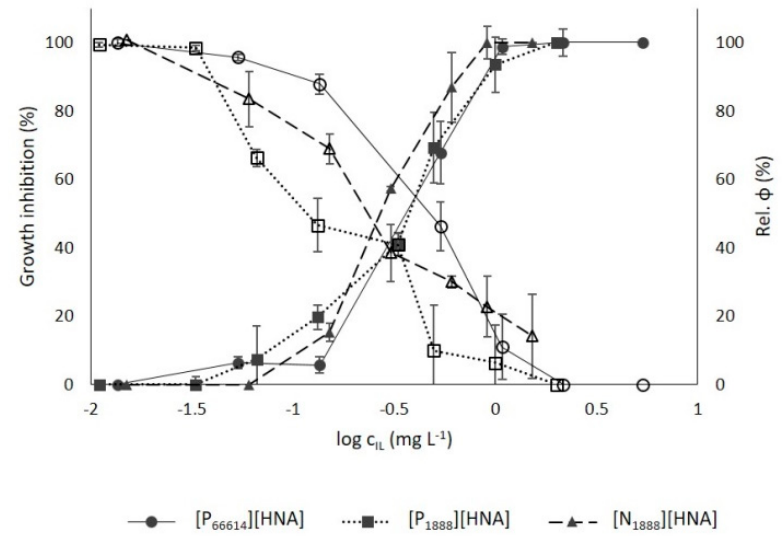
Figure 3. Effect of the three ILs on algal growth (filled symbols) and chlorophyll fluorescence (Rel. φ , open symbols) in 72 h acute toxicity assays with Raphidocelis subcapitata , n=3, error bars = ± SD.